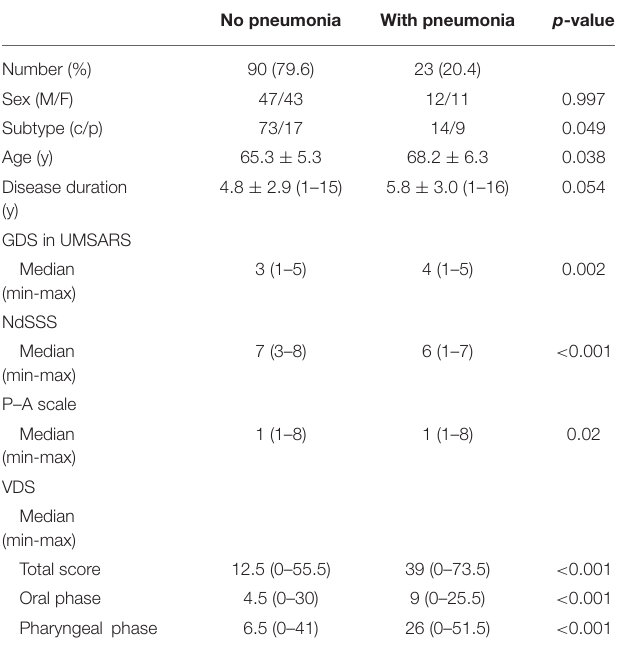
TABLE 6 | Difference in swallowing function by history of pneumonia in patients with multiple system atrophy.